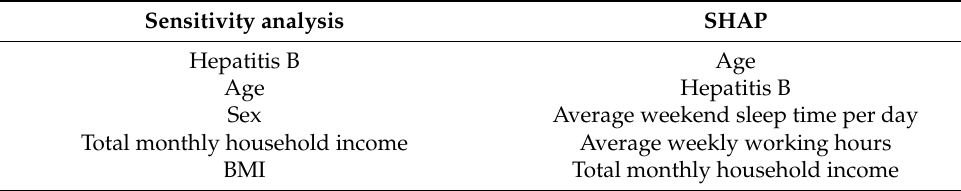
Table 13. The top 5 significant features of the sensitivity analysis for liver cancer risk association